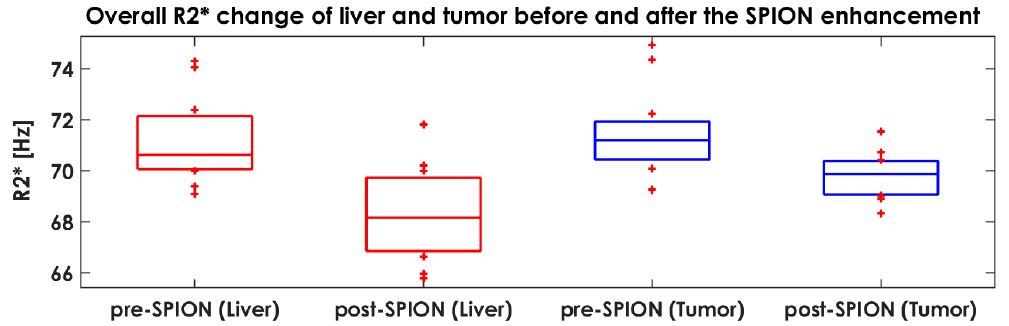
Figure 6. Overall R2* change in healthy livers and tumors before and after the SPION enhancement. The first two (red color) boxplots represent the R2* of the liver in pre- and post-SPION, and the last two (blue color) boxplots represent the R2* of the tumor in pre- and post-SPION.